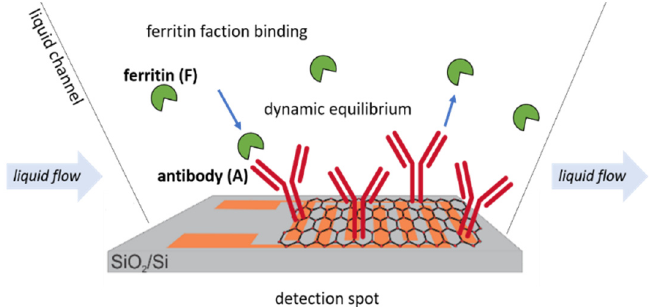
Figure 4. Schematic representation of the dynamic equilibrium of ferritin antigens to immobilized antibody receptors on the active GFET sensor area.